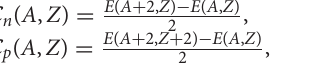
Binding energy per nucleon (MeV) of the initial nuclei are compared to those of the intermediate fused system, and the corresponding experimental values are shown in parenthesis